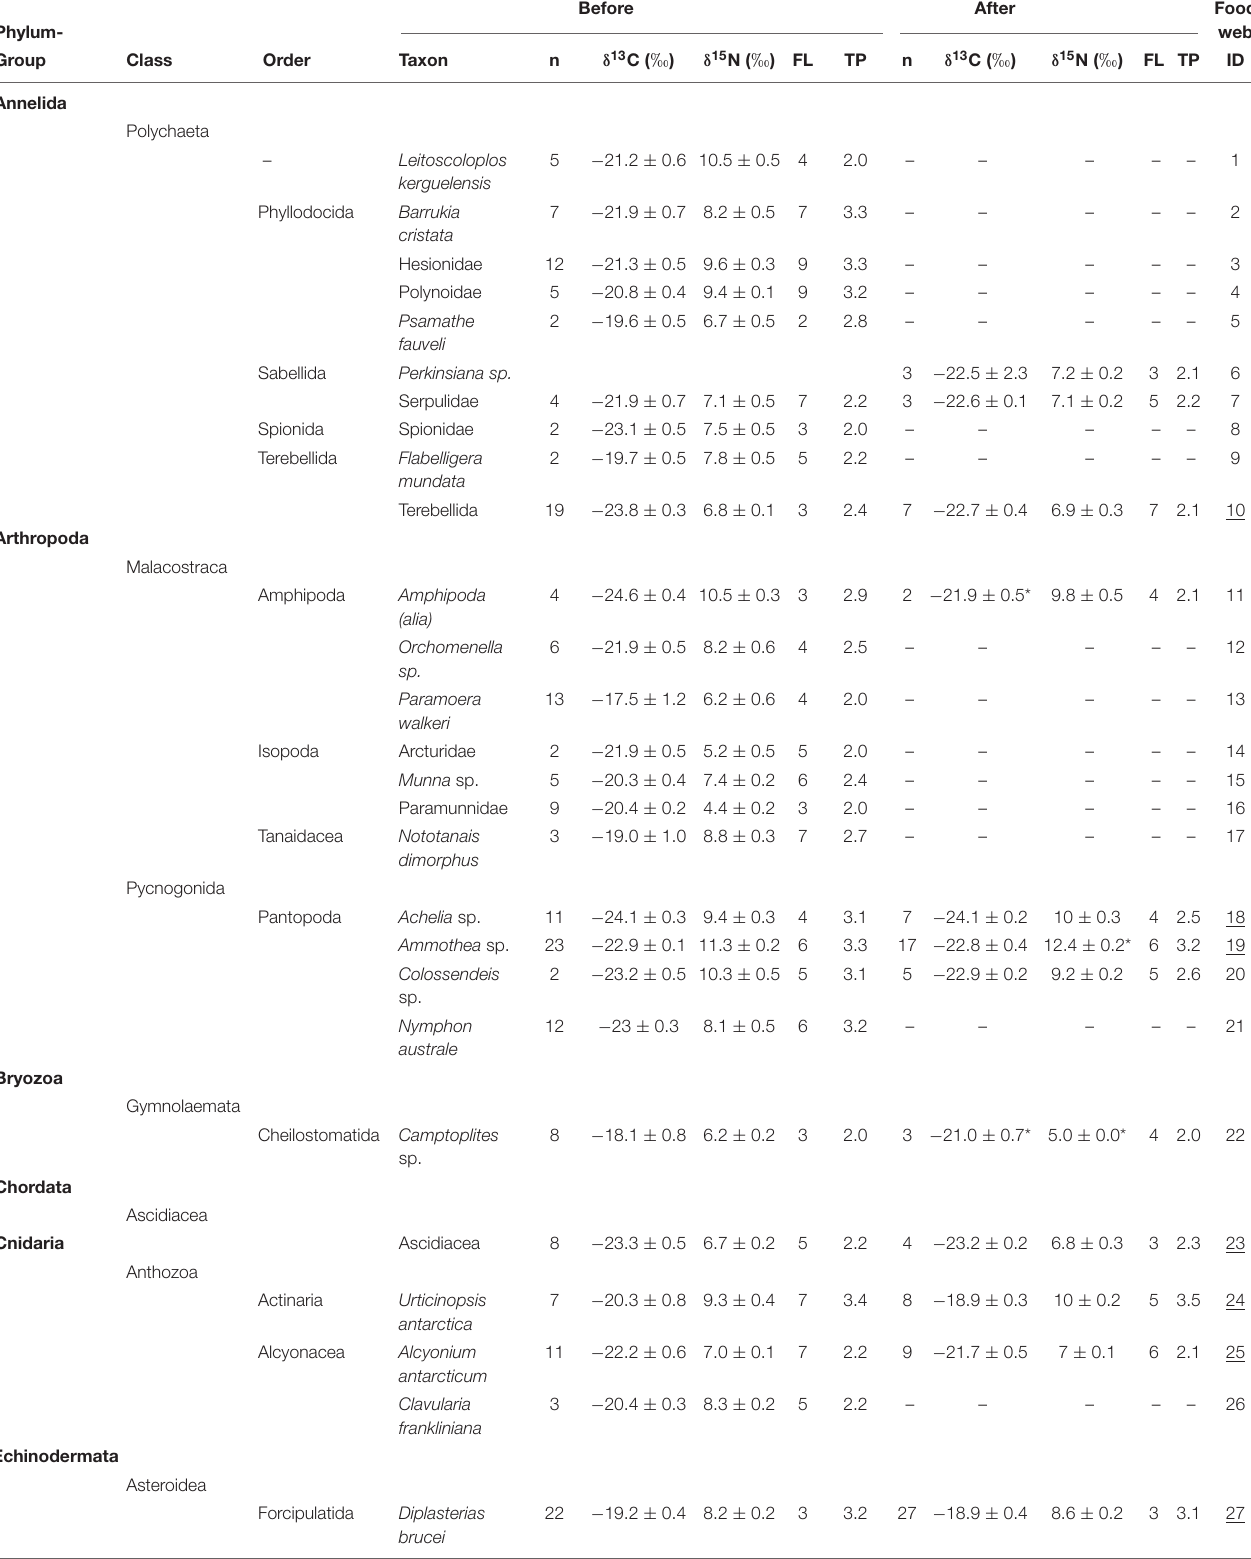
TABLE 1 | Community carbon ( δ 13 C) and nitrogen ( δ 15 N) isotopic signatures (mean ± SE) BEFORE and AFTER.